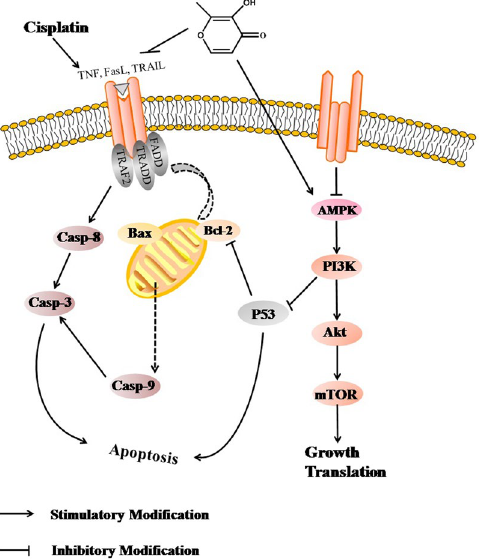
Figure 7. Scheme summarizing the inhibition of cisplatin-induced nephrotoxicity by maltol via the down- regulation of AMPK through PI3K/Akt